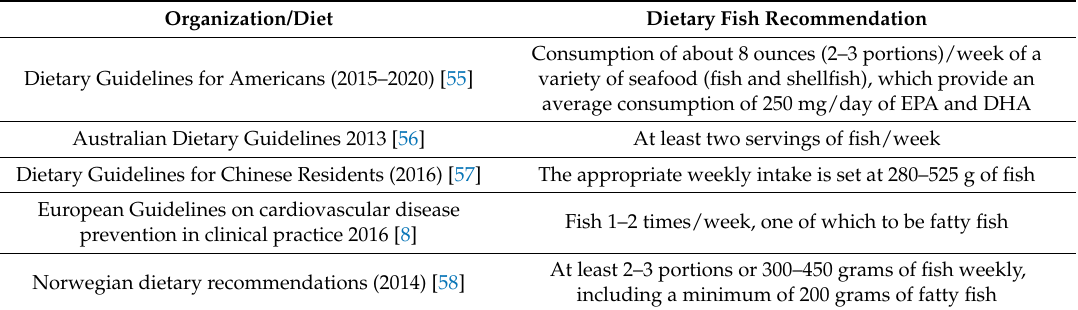
Table 6. Current dietary recommendations from various governing